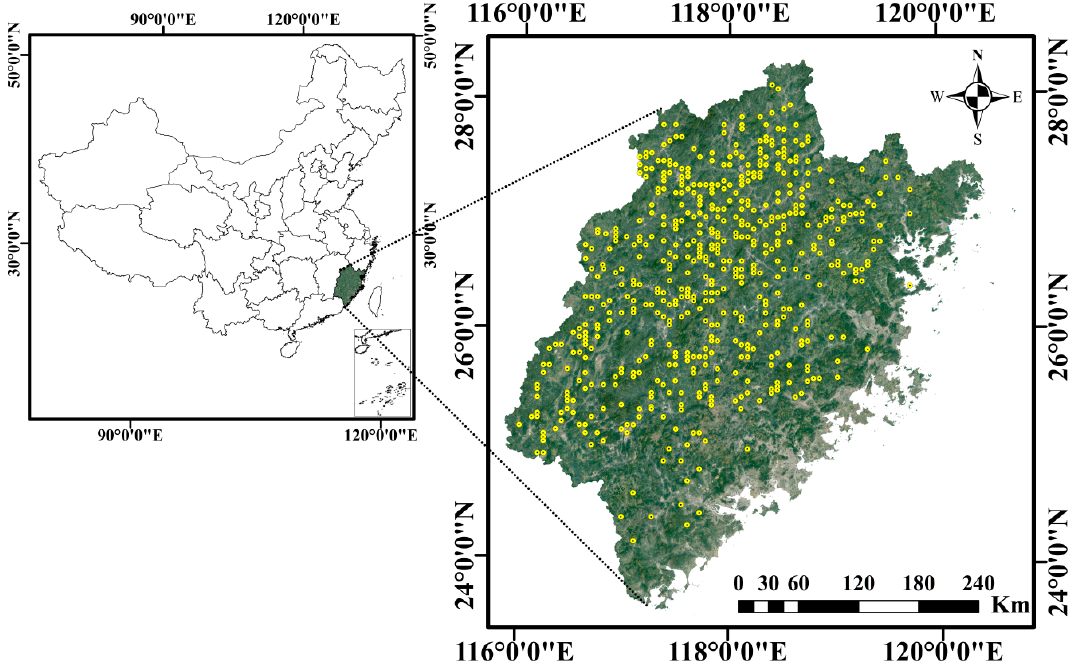
Figure 1. Geographical distribution of the inventory sample plots within pure China fir stands. Table 1. Descriptive statistics of stand and site variables for pure China fir plantations ( n = 553) 1 .